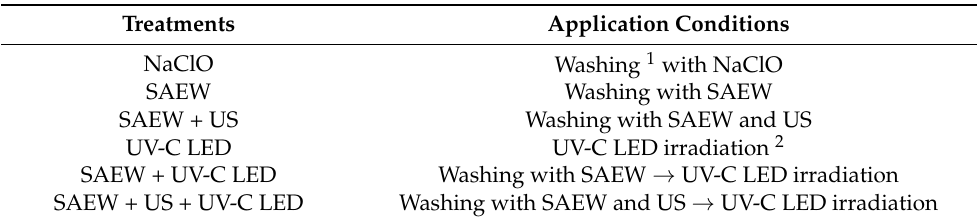
Table 1. Application conditions of single or combined treatments with SAEW, US, and UV-C LED applied for fresh-cut